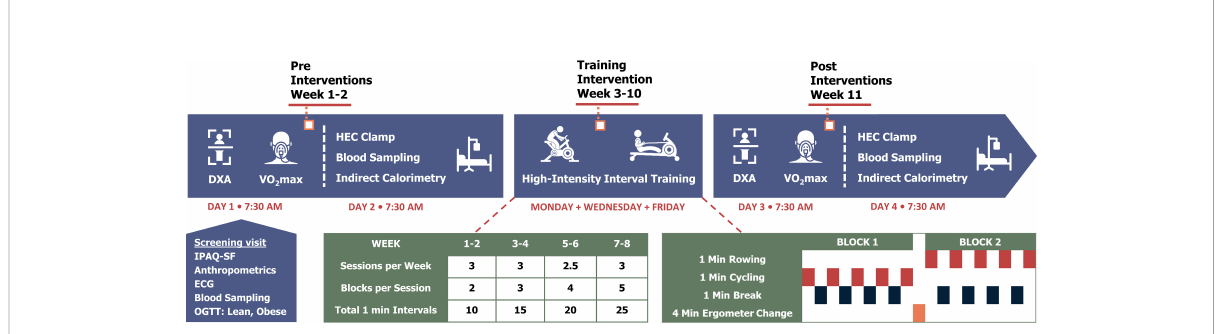
FIGURE 1 Study experimental design. HEC, hyperinsulinemic-euglycemic clamp; IPAQ-SF, International Physical Activity Questionnaire Short Form; OGTT, oral glucose tolerance